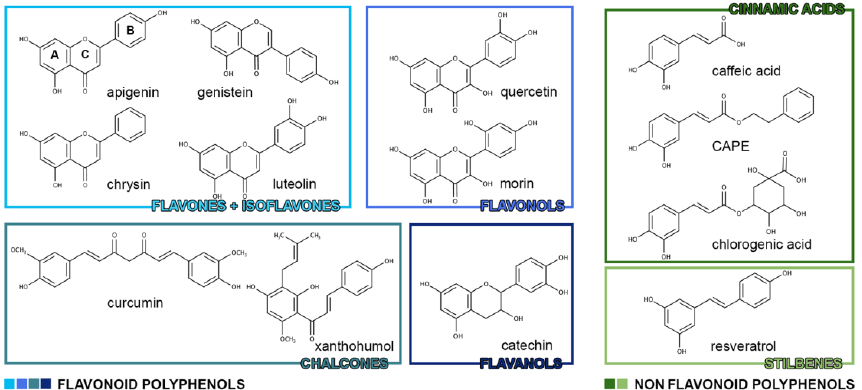
Figure 1. Chemical structures of polyphenols that are connected with a sphingolipid-based mechanism for cancer prevention and treatment. for cancer prevention and